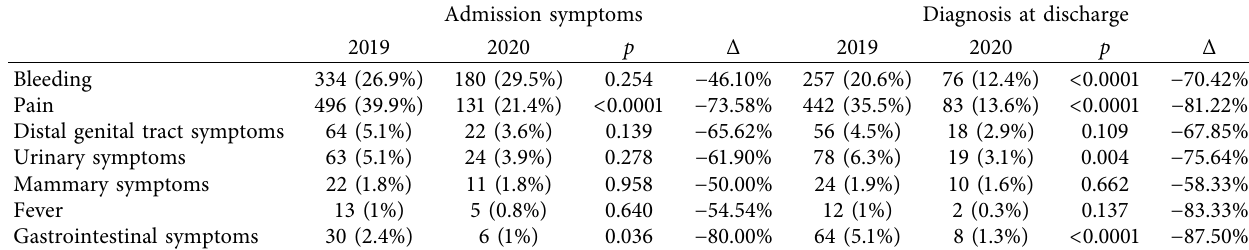
Table 3: General population admission and